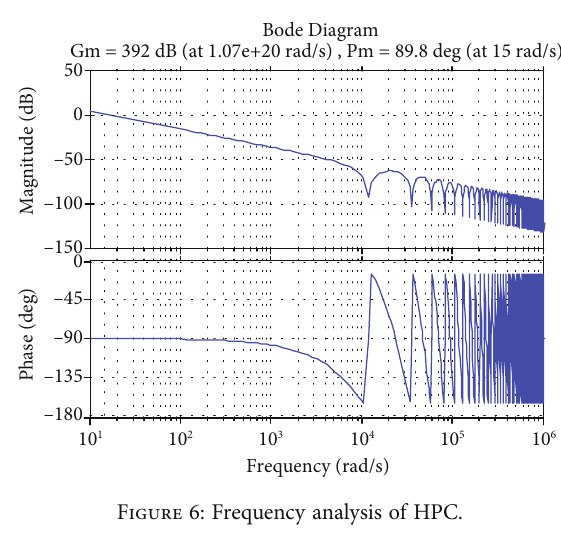
Figure 6: Frequency analysis of